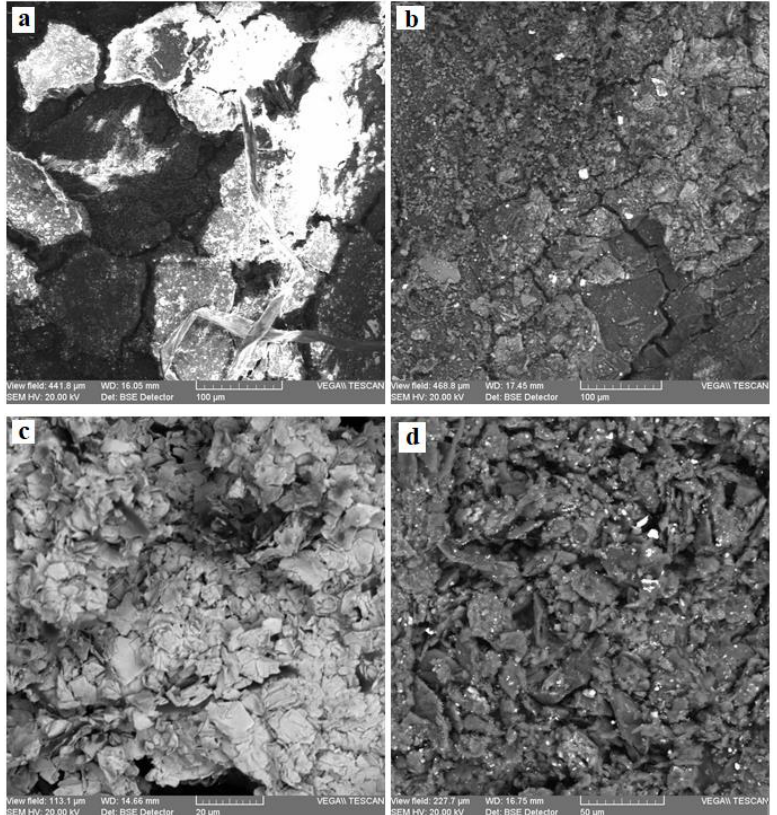
Figure 9. SEM microphotographs for the inks of document S1: ( a ) S1-PR (×500); ( b ) S1-PV (×500); ( c )